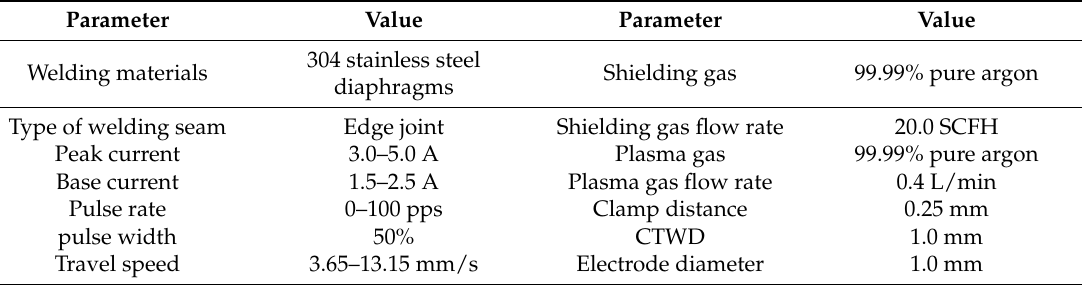
Figure 7. The schematic diagram of micro plasma arc welding experimental apparatus. Table 1. Experimental condition of MPAW for 304 stainless steel diaphragms.